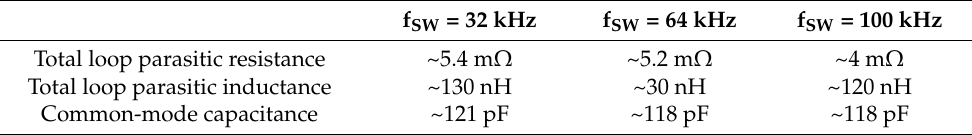
Table 1. Values of the experimentally extracted parasitics at the frequencies of interest.